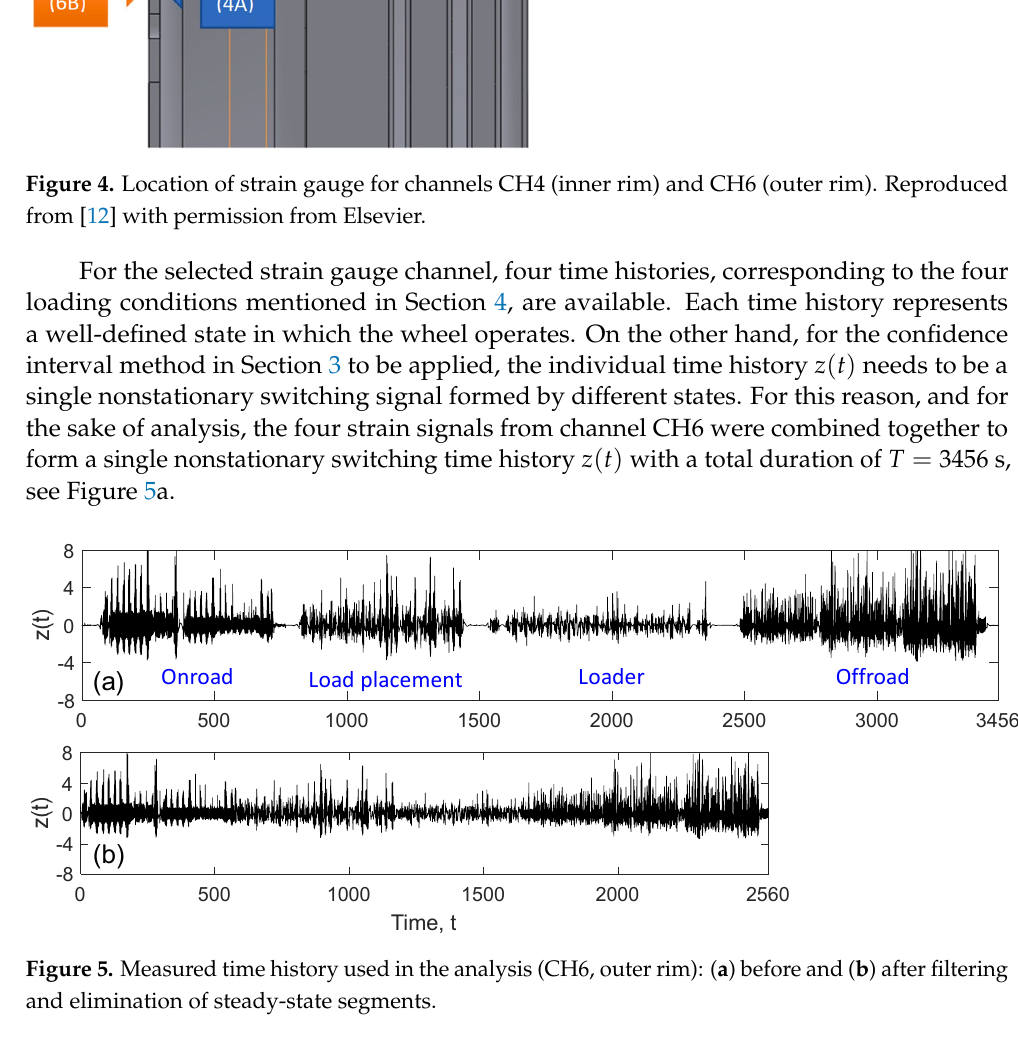
Figure 5. Measured time history used in the analysis (CH6, outer rim): ( a ) before and ( b ) after filtering and elimination of steady-state segments.